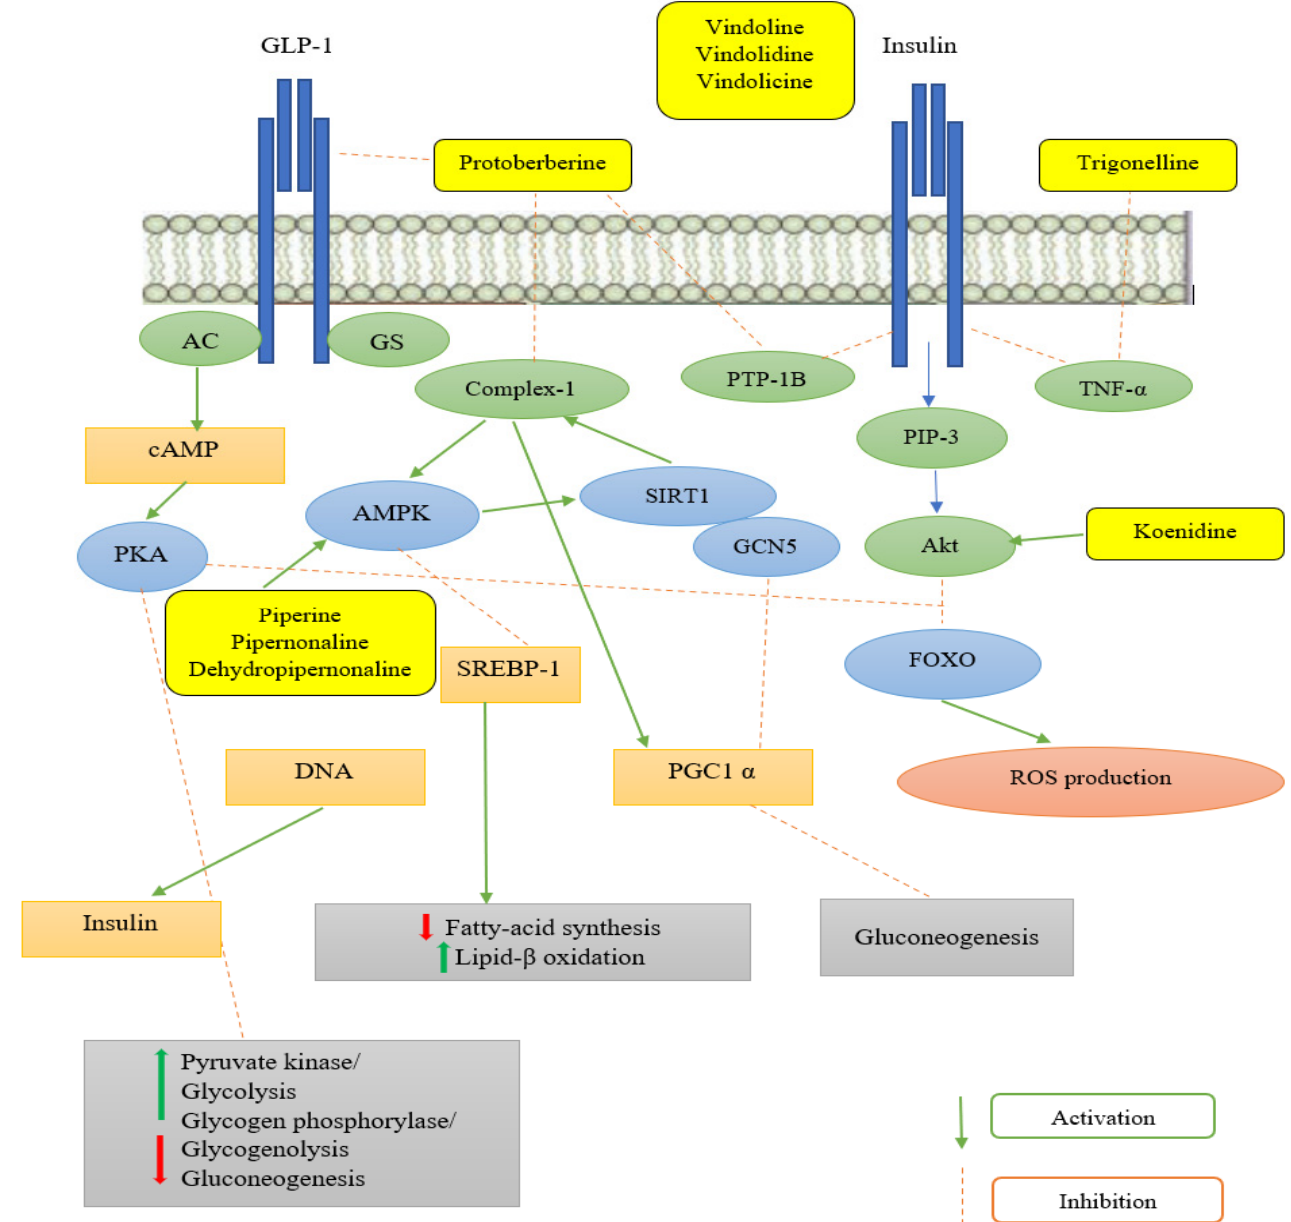
Figure 3. Regulation and management of diabetes mellitus through cellular signaling mediated by alkaloidal